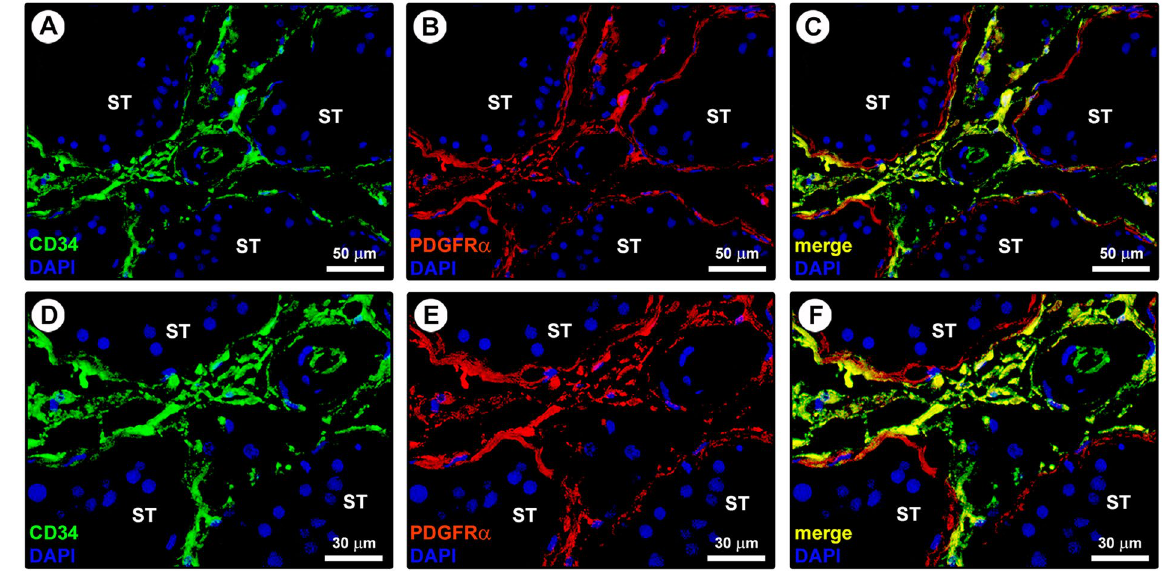
Figure 4. Double immunostaining of human testis sections. ( A–F ) Representative photomicrographs of immunofluorescence staining for CD34 (green) and platelet-derived growth factor receptor α (PDGFR α ; red) with 4 ′ ,6-diamidino-2-phenylindole (DAPI; blue) counterstain for nuclei. Single green and red images are shown in ( A,D ) and ( B,E ), respectively, while merge images are shown in ( C,F ). All CD34-positive interstitial cells located in the outer layer of the connective tissue around the seminiferous tubules (ST) and in the intertubular stroma coexpress PDGFR α (yellow staining). PDGFR α immunoreactivity is also found in